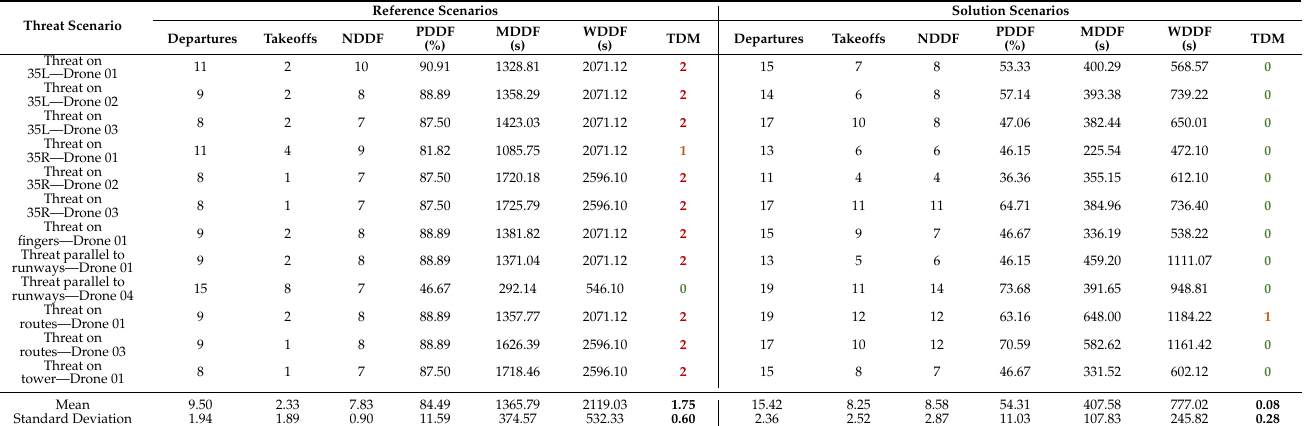
Table A3. Simulation results: time performance metrics. The following colors are used for TDM values: red for high (2) value; orange for medium (1) value; green for low (0) value. Bold values respectively represent the mean and the standard deviation of TDM values.